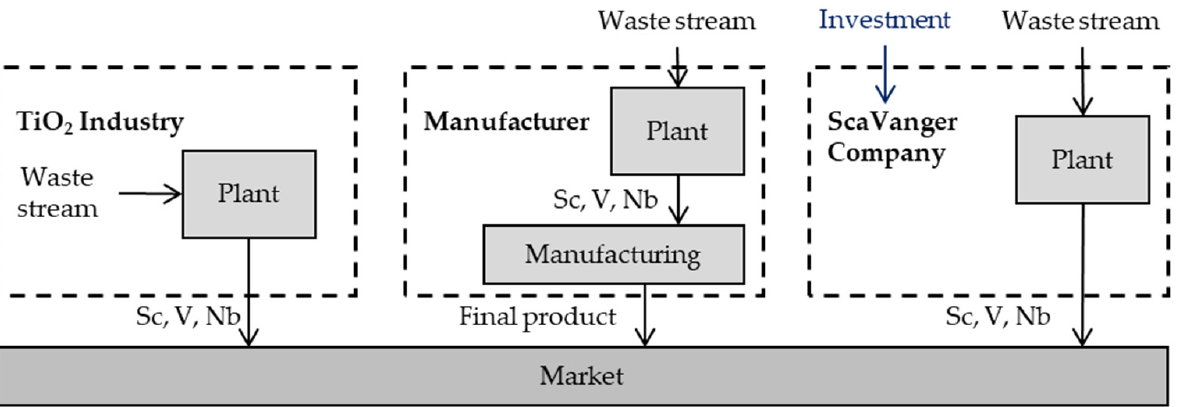
Figure 3. ScaVanger business partnership models.